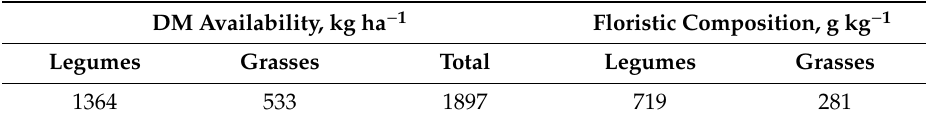
Table 1. Herbaceous stratum availability, expressed as DM, and floristic composition of Caatinga -native pasture in the rainy